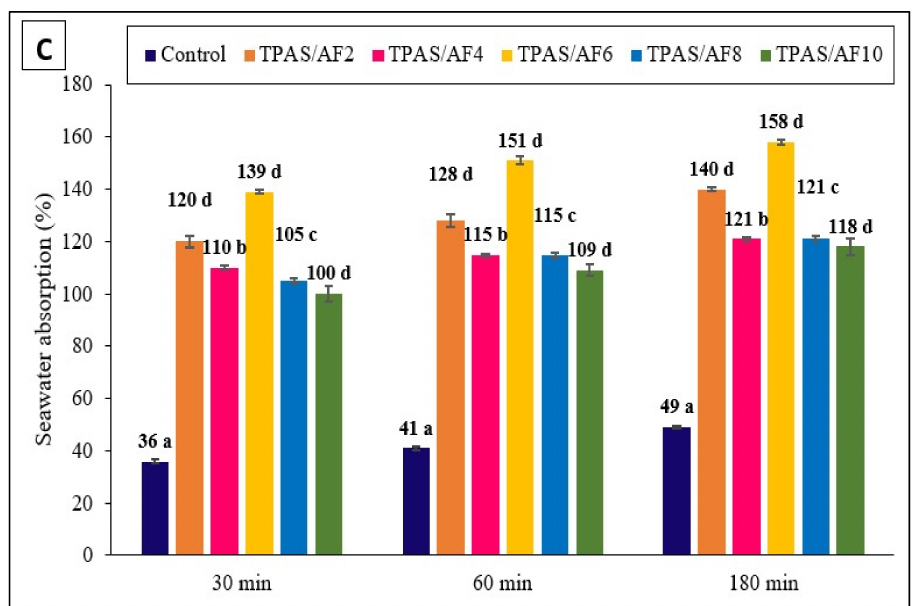
Figure 2. Water absorption (%) versus immersion time for the control and TPAS/AF composites in ( A ) distilled water; ( B ) rainwater; and ( C ) seawater. Values with different letters in the figures are significantly different ( p < 0.05).